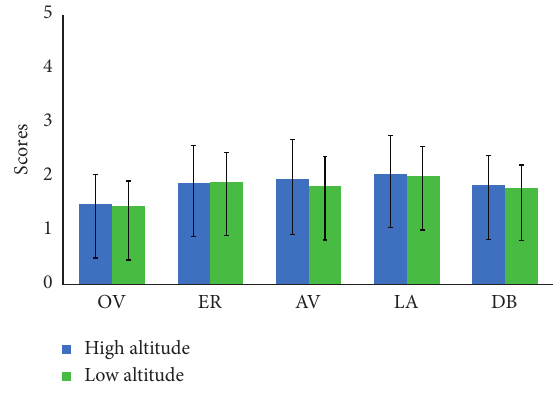
Figure 3: Scores of driving behaviour.